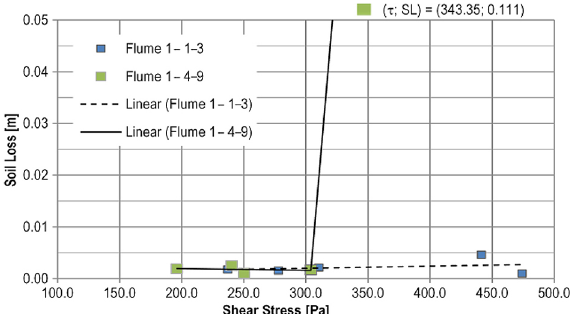
Fig. 10. Erosion rates flume 1 (vegetated); soil loss and shear stress, steep trend line = high erosion rate, focus on the upper (“1–3”) and lower (“4–9”) flume parts, September 2014